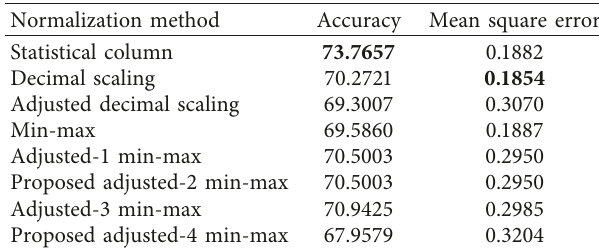
Table 6: Comparative results of prediction efficiency on Indian liver disease dataset yielded by every tested normalization method.